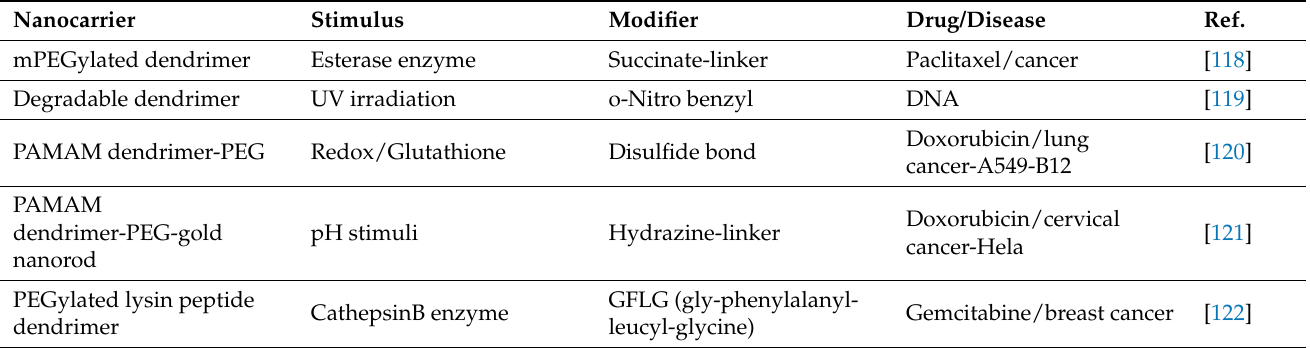
Table 3. Examples of stimuli responsive dendrimers are